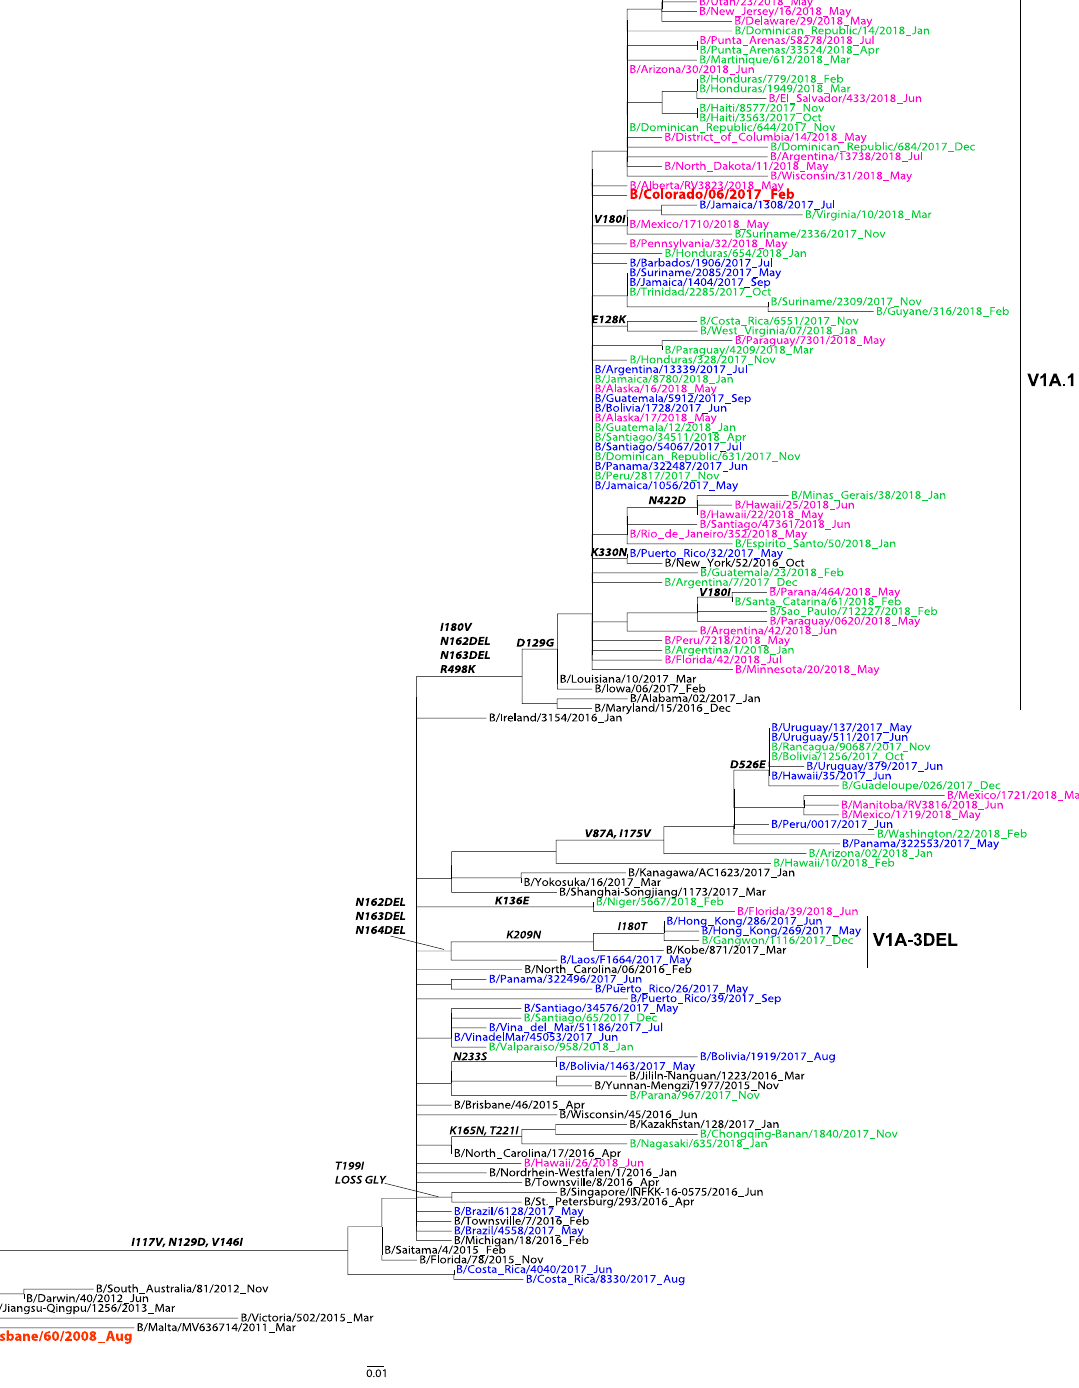
Fig 5. Representative maximum-likelihood tree of n = 76 influenza B virus Victoria HA gene sequences from Mexico, South and Central America; sequences from the current and previous vaccine strains (in red) and reference viruses detected worldwide indicated by the CDC WHO CC. HA sequences of influenza viruses collected from May to September 2017 are in blue, October 2017 to April 2018 are in green, May to September 2018 are in pink. Sequences from the time period before the period of analysis, are in black. Amino acid changes and addition (ADD GLY) and loss (LOSS GLY) of glycosylation sites are indicated in bold in the branches